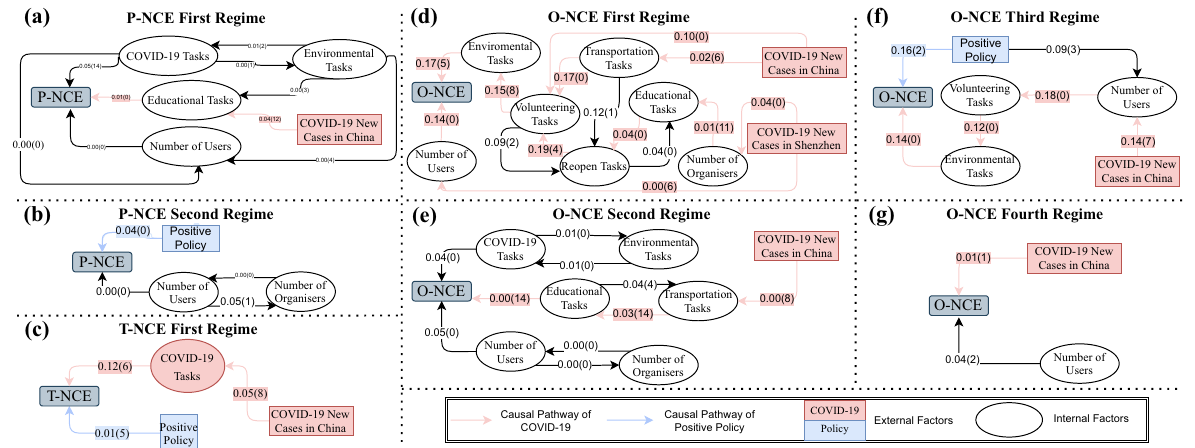
Fig. 6 Causality graph for participation rate NCE, organiser preference NCE (O-NCE), and task preference NCE (T-NCE). a , b Causality graph for two P-NCE regimes. c Causality graph for the T-NCE regime. d – g Causality graph for four